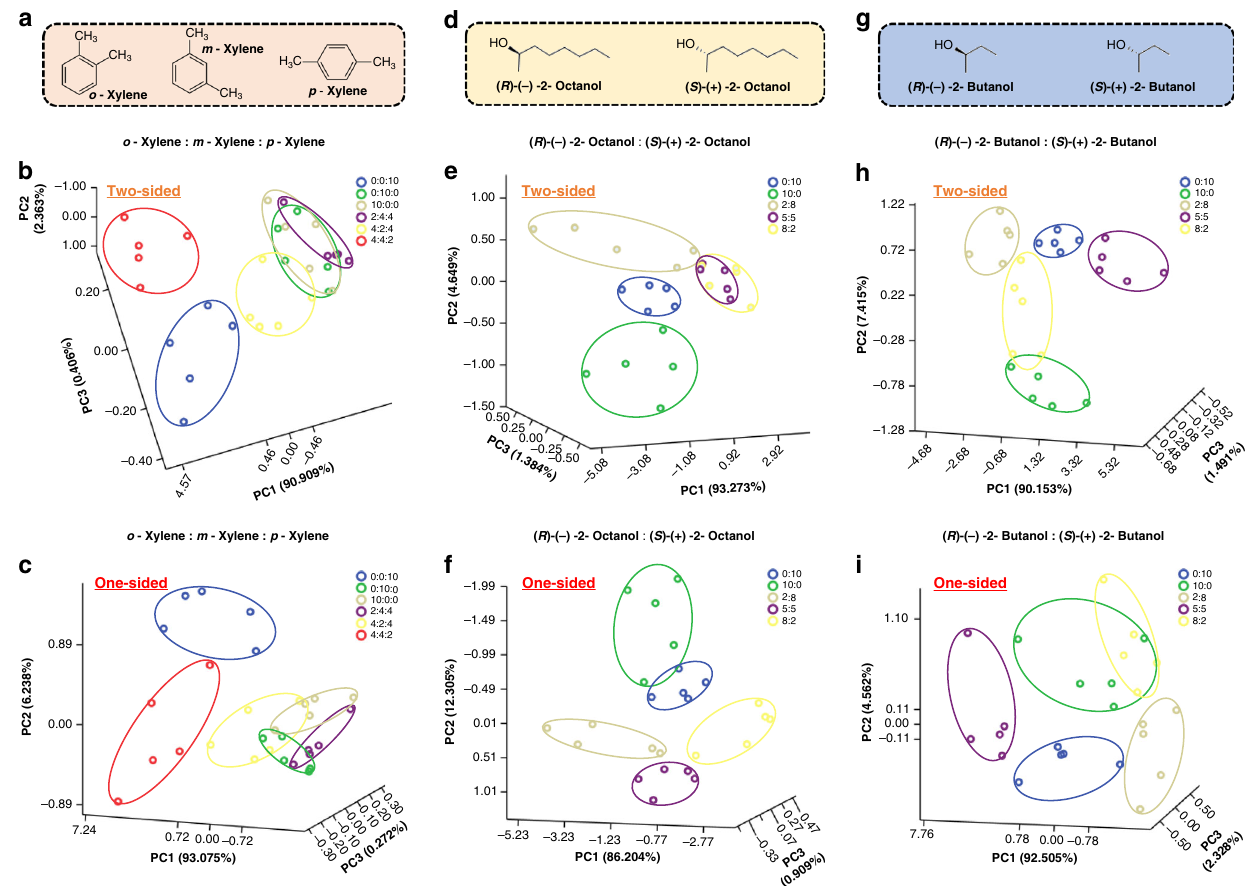
Fig. 4 Identi fi cation of structural isomers and chiral recognition of enantiomers. a Structural formula of Xylene isomers. Three-dimensional (3D) canonical score plots for two-sided origami OHSA ( b ) and one-sided OHSA ( c ) against Xylene isomers (10 ppm) and their mixtures at the indicated different mass ratios, respectively. Structural formula of 2-Octanol enantiomers ( d ) and 2-Butanol enantiomers ( g ). 3D canonical score plots for two-sided OHSA ( e , h ) and one-sided OHSA ( f , j ) against 2-Octanol enantiomers (10 ppm) and 2-Butanol enantiomers (10 ppm) and their mixtures at the indicated different mass ratios,